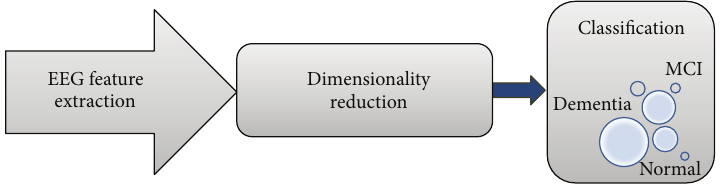
Figure 11: Block diagram of EEG features dimension